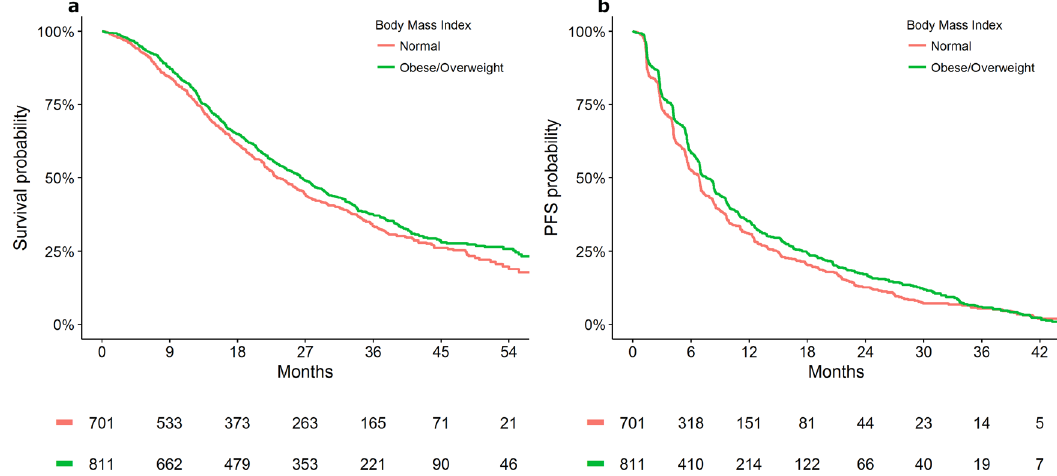
Fig. 3 Kaplan – Meier plot representing survival outcomes in the later-line therapy cohort by BMI status in advanced breast cancer [Data from EMILIA and TH3RESA study]. a Overall survival; b progression-free